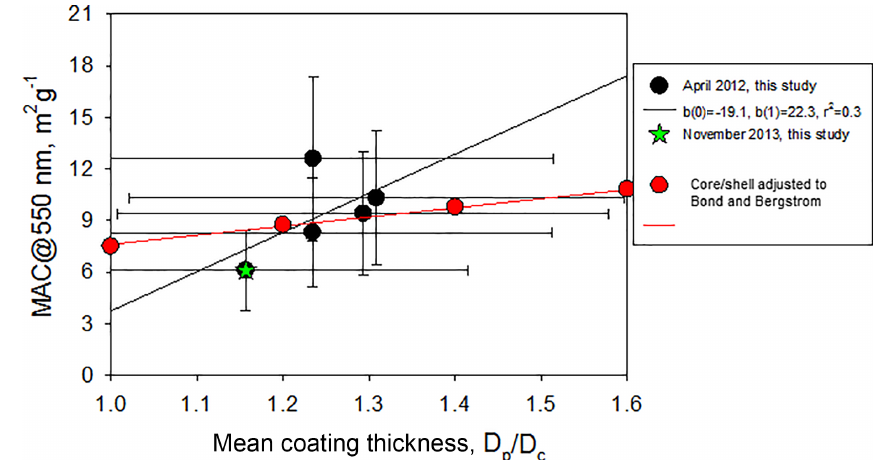
Figure 10. The comparison between the MAC and weekly averaged mean coating thickness shows a positive and significant relationship ( p <0.001). Aerosols seem to have thicker coatings in April (black circles) than in November (green star); also note that only values above the detection limits for MAC were considered. Red circles are adjusted core–shell to Bond and Bergstrom (2006) for uncoated particles at 7.5m 2 g − 1